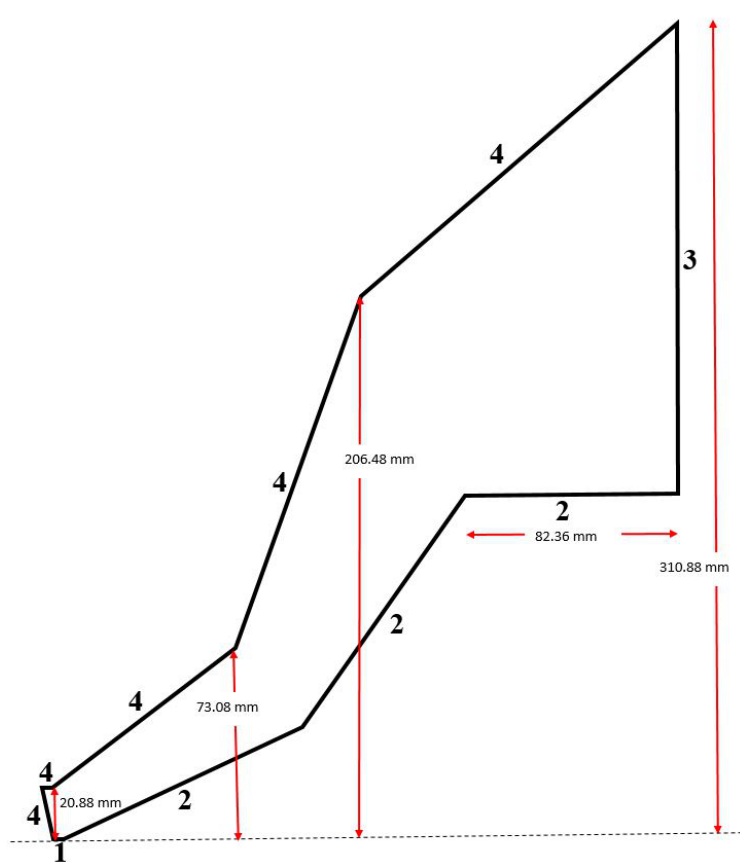
Figure 2. Extent of the domain and boundary conditions. 1: Axis of symmetry; 2: no slip, constant wall temperature; 3: zero gradient; 4: freestream